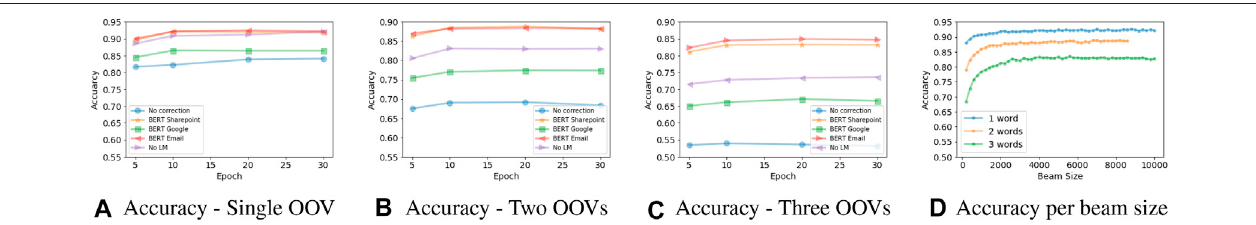
FIGURE5| Asexpected,misspelledwordscansigni fi cantlydecreaseintentclassi fi cationperformance.ThesameBERTmodelthatachieved94%oncleandata,dropped